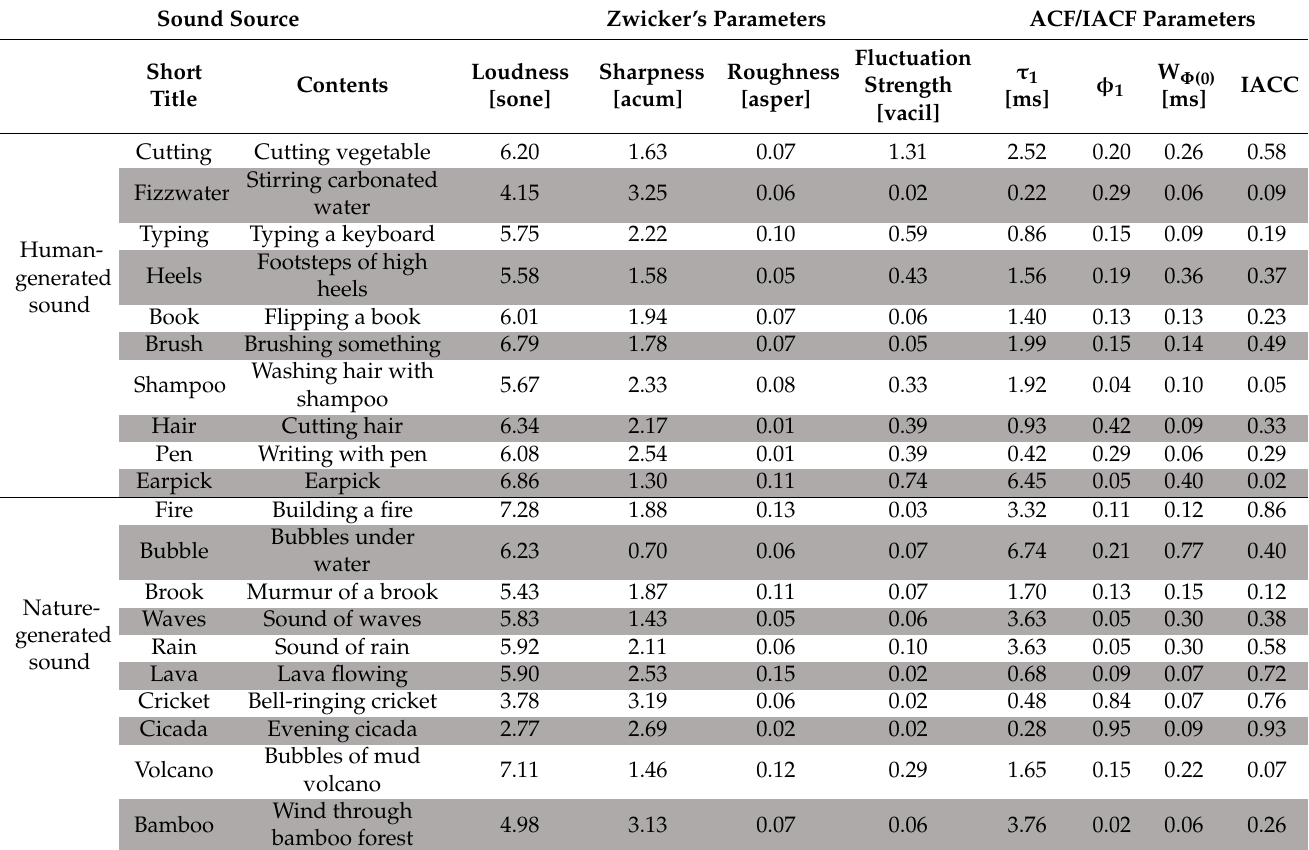
Table 1. Human- and nature-generated sounds and calculated Zwicker’s and ACF/IACF